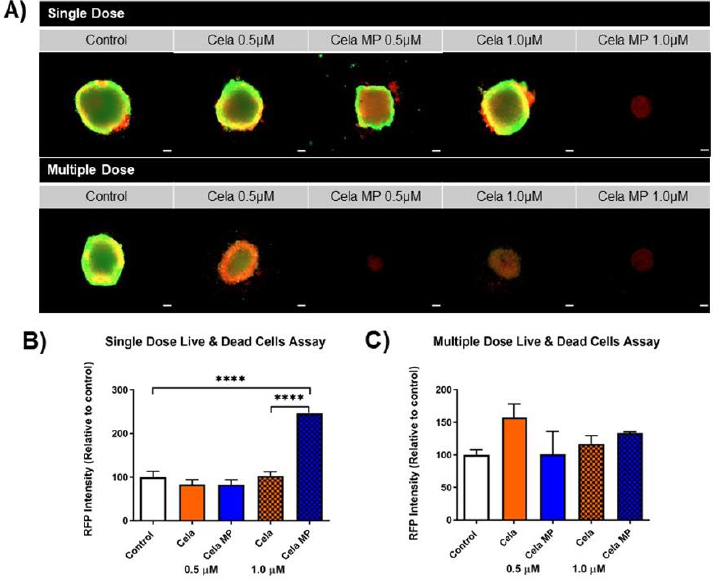
Figure 9. Live/Dead cell assay performed using Viability/Cytotoxicity Assay Kit for Animal Live & Dead Cells on day 15 MSTO-211H 3D spheroids. ( A ). Representative images (4× magnification) of stained spheroids for both single and multiple-dose 3D spheroid studies. GFP depicts live cells while RFP depicts compromised/dead cells. Scale bar for the images represents 500 μ m. Quantitative representations of percent RFP fluorescence intensity of each treatment for ( B ). single-dose and ( C ). multiple-dose 3D spheroid study. Control was considered 100%. Data represent mean ± SEM (n = 3). Significance between groups was analyzed by one-way ANOVA and Tukey’s multiple comparisons test. **** p < 0.0001.